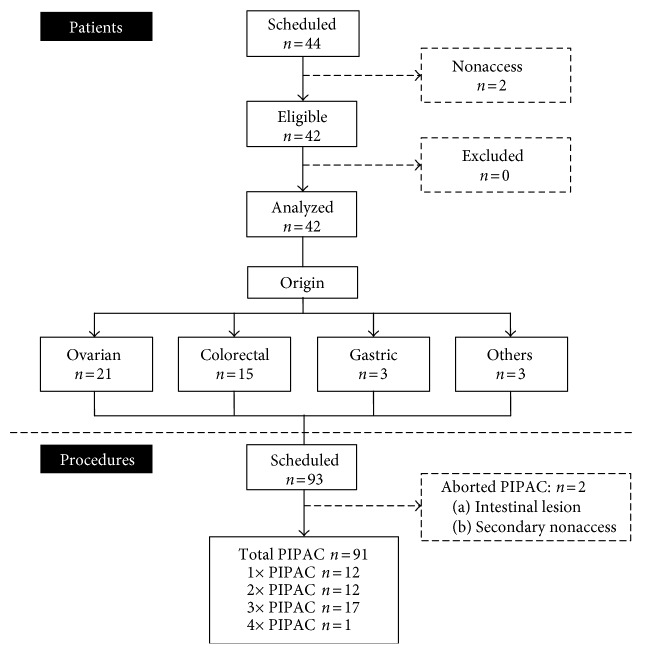
Flow of patients treated with pressurized intraperitoneal aerosol chemotherapy (PIPAC).